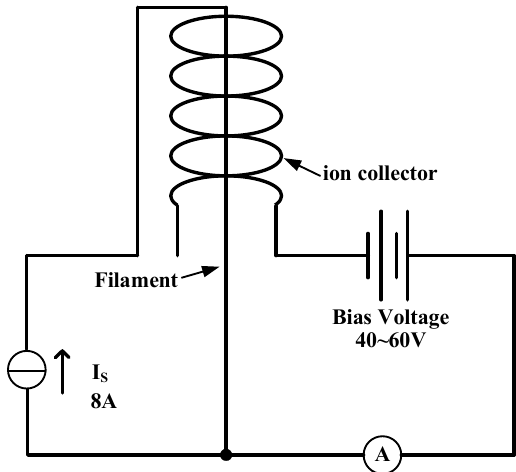
Figure 10. SID circuit connection.